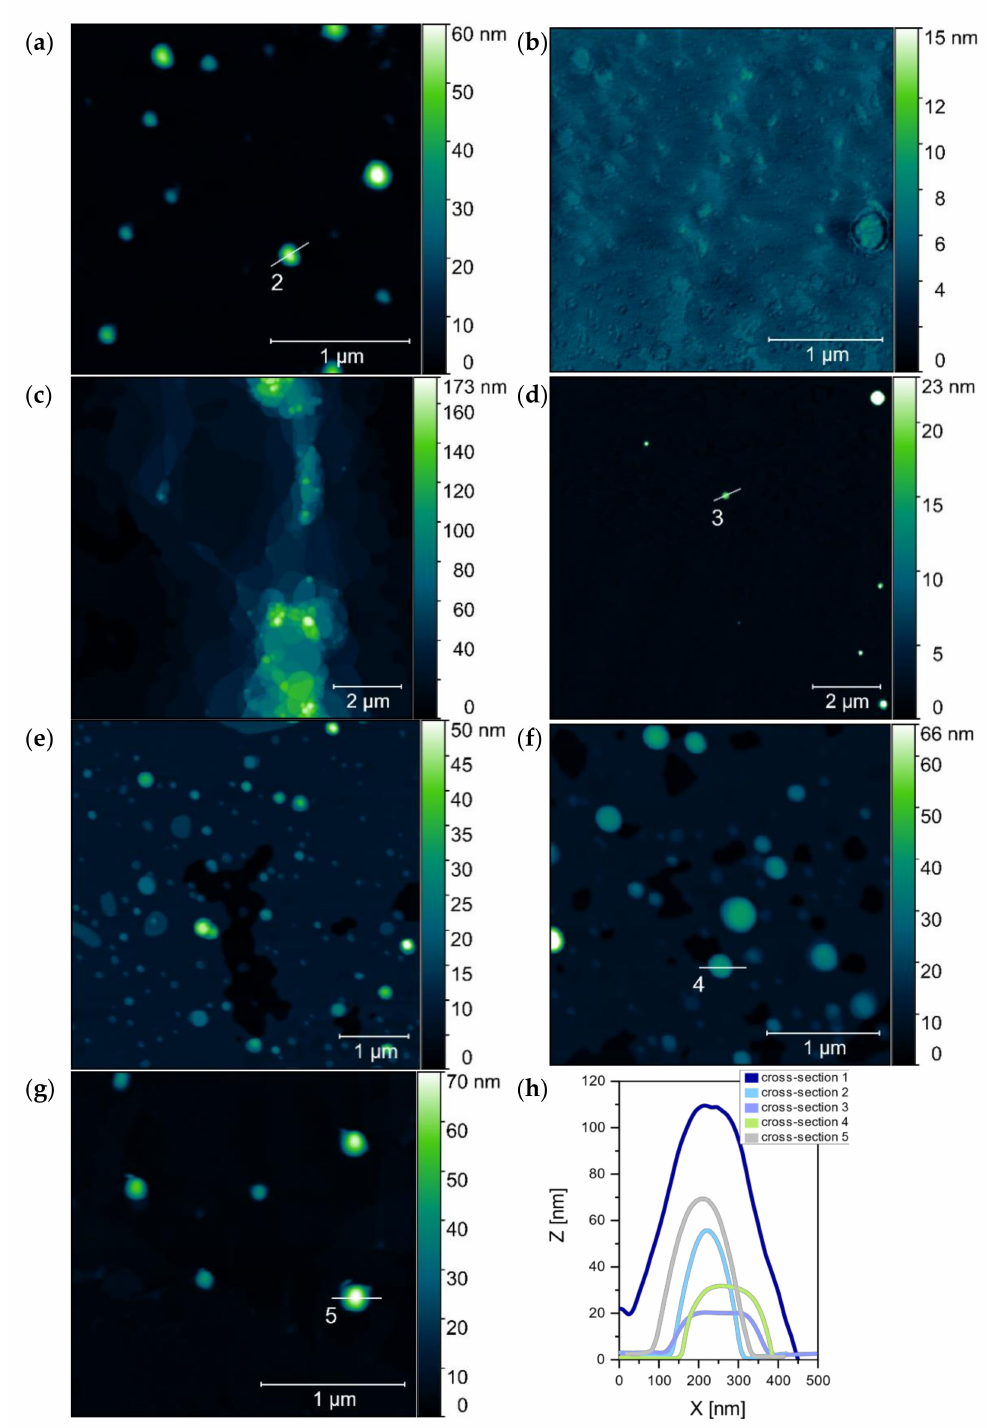
Figure 13. AFM images of the studied complexes based on TRI_N surfactant: ( a ) TRI_N/DNA_20kbp, p/n = 5 ( b ) TRI_N/L1/DNA_20kbp, p/n = 5 ( c , d ) TRI_N/L2/DNA_20kbp, p/n = 5 ( e , f ) TRI_N/L3/DNA_20kbp, p/n = 5 ( g ) and TRI_N/DNA_20kbp, p/n = 8 ( h ) together with a set of cross-sections highlighted on panels ( a , d , f , g ) and Figure 12c. Complexes based on TRI_IMI surfactant (p/n = 5) were also analyzed in terms of their topography. This surfactant also promoted the creation of stable complexes together